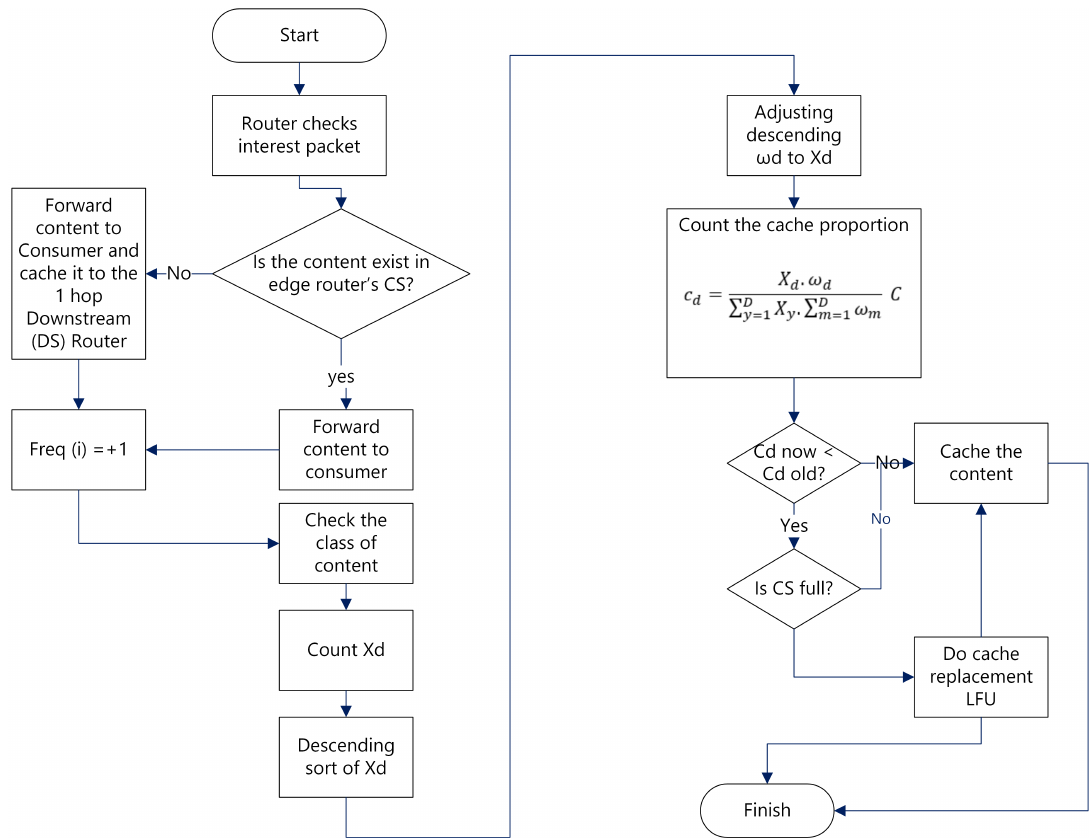
Figure 1. Flowchart of Weighted